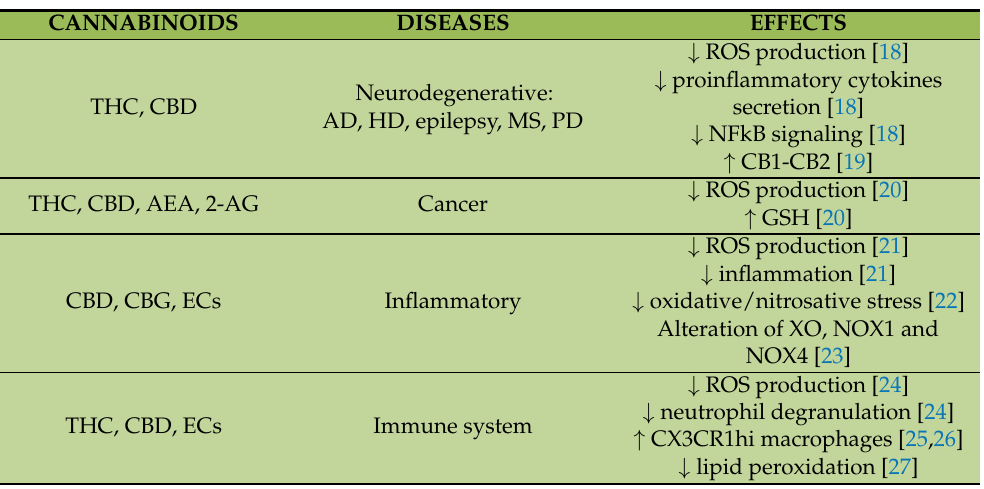
Figure 2. Schematic overview of CBD inhibitory effects on ROS cellular production. CBD modu- lation of oxidative stress is the basis of its effectiveness in ameliorating the symptoms of disease. Table 1. Effects of cannabinoids in different diseases. AD: Alzheimer’s disease; HD: Huntington’s disease; MS: Multiple sclerosis; PD: Parkinson’s